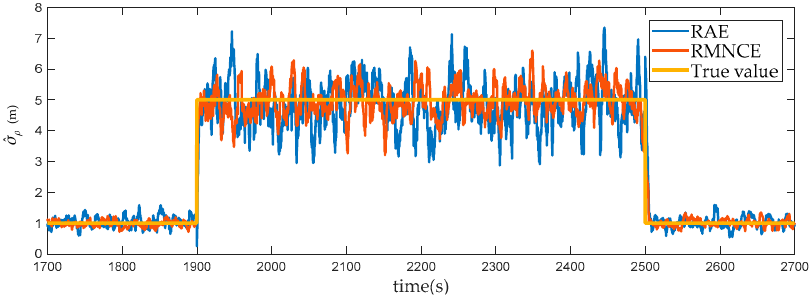
Figure 5. The estimated variances of the pseudo-range measurement noise obtained by RAE and RMNCE.